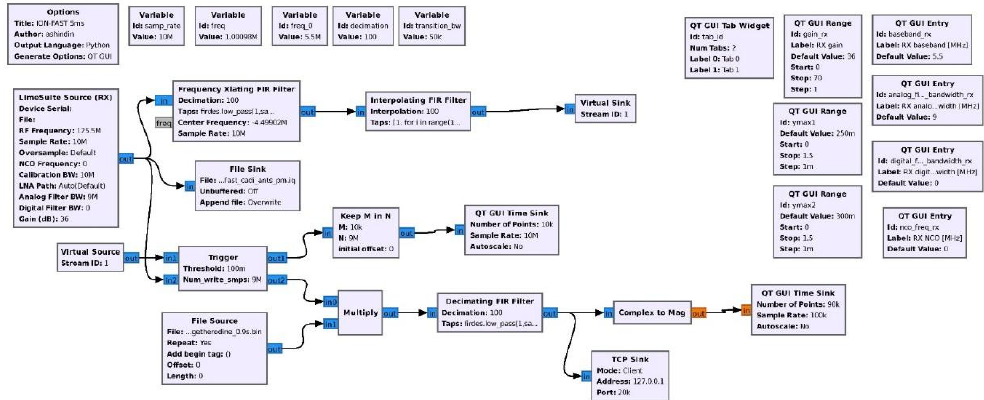
Figure 5. GNU Radio Companion flowgraph used in ionosonde’s receiving part.